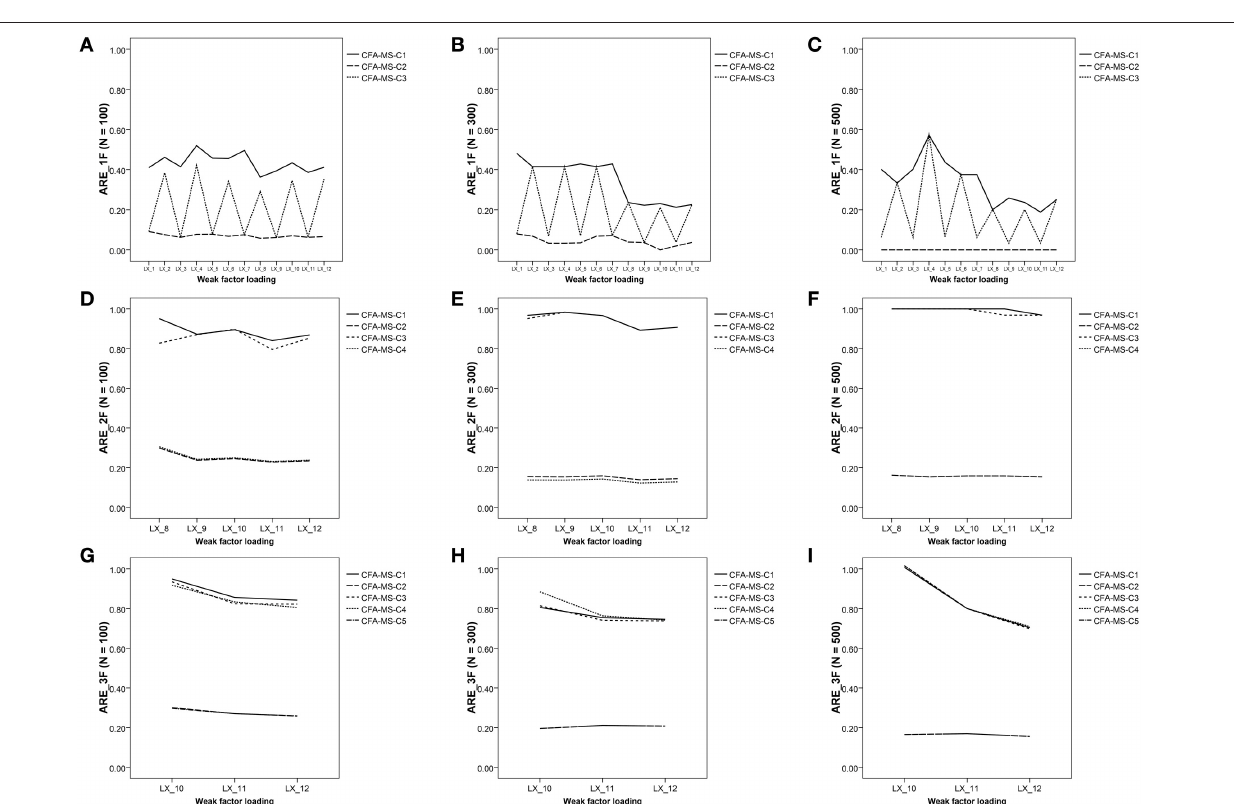
100 ); (B) ARE = 300 ); (F) ARE values in = 500 =